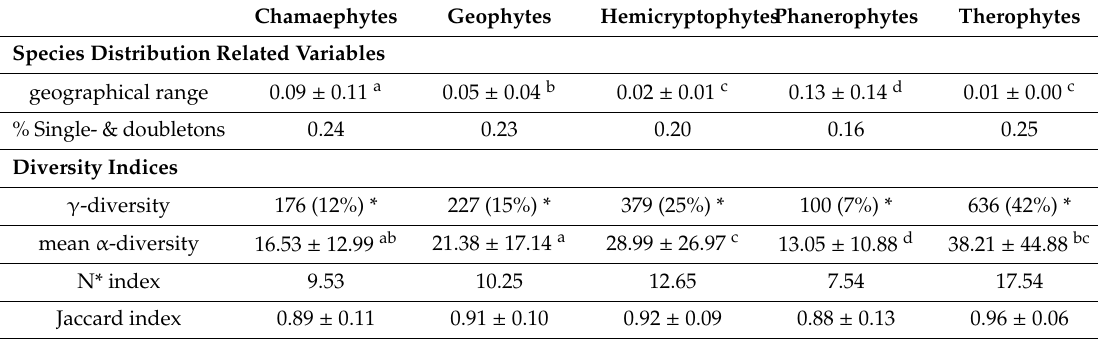
Table 1. Species distribution related variables and diversity indices of species of di ff erent life forms. Di ff erent letters (a, b, c, d) indicate significant di ff erences between life forms, according to permutational one-way